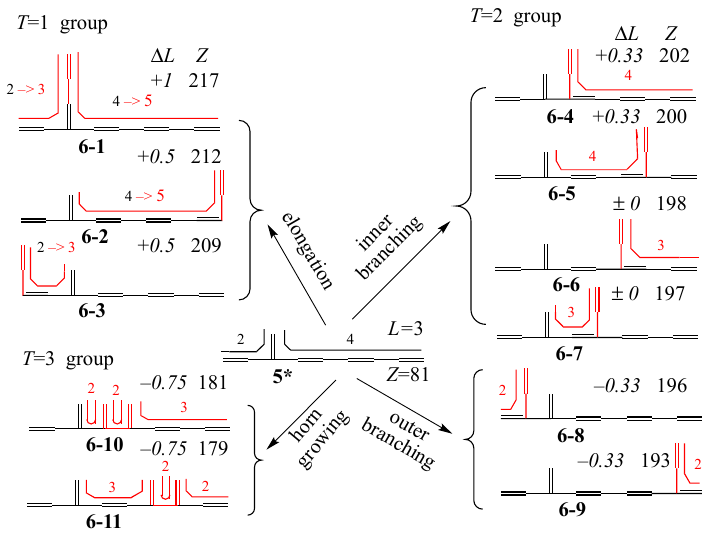
Figure 9. Diagram showing the change of conjugated paths (in red) in each C 12 isomer caused by the addition of a vinyl group and horn growing to 5* . Δ L (in italics) and Z for each isomer are also given.